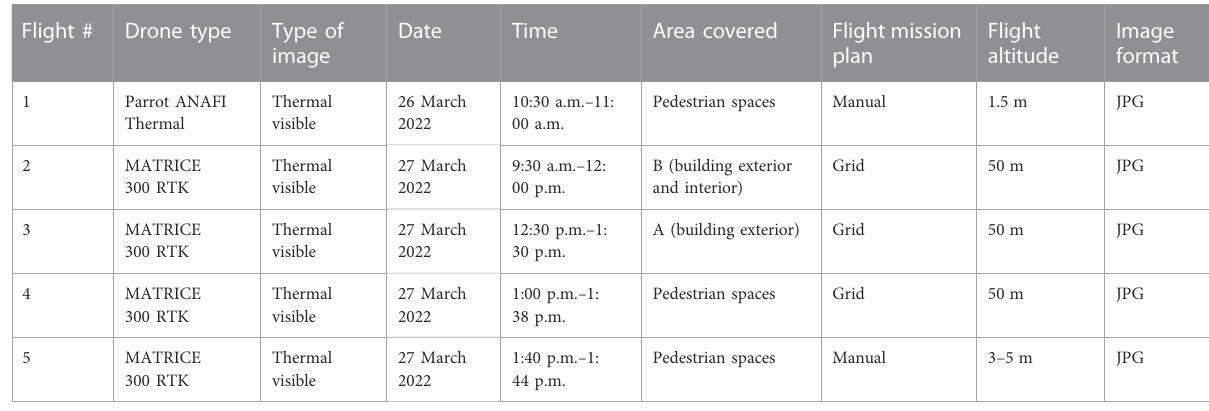
TABLE 2 Flights Planning and aerial